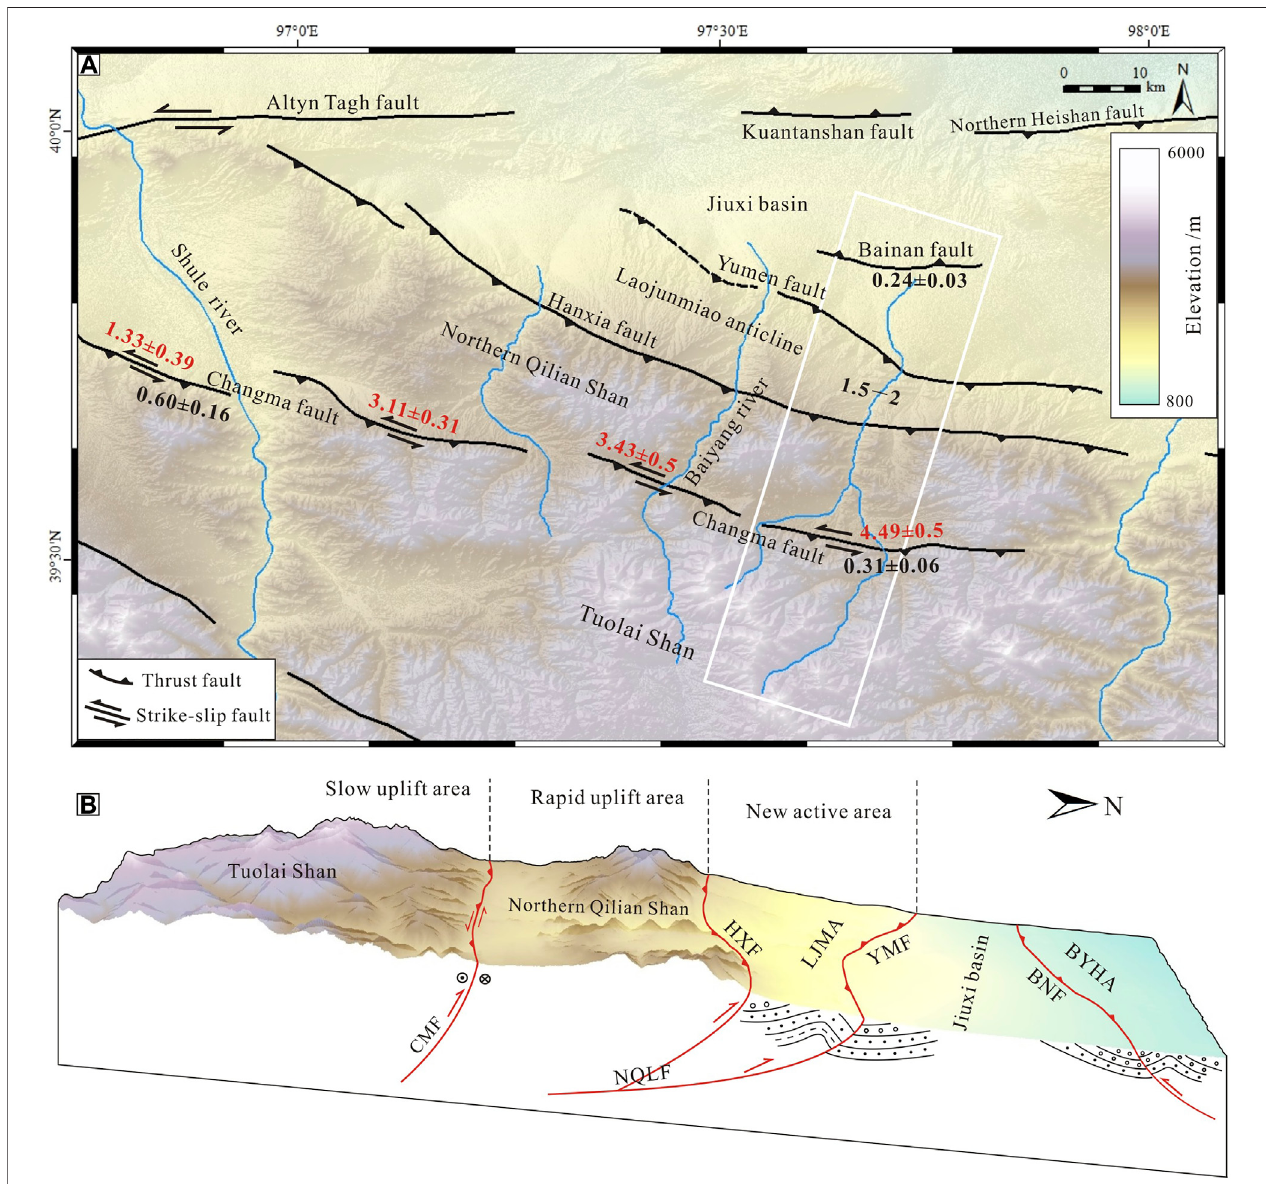
FIGURE 9 | (A) Slip rates of active faults in the northwestern Qilian Shan. The black numbers represent the uplift slip rates of the faults; the red numbers represent the sinistral slip rates of the faults. The slip unit is mm/a. The sinistral strike-slip rates of the Changma fault increase from west to east, but the vertical slip rates decrease fromwesttoeast. (B) Thethree-dimensionaltopographicmapoftheBaiyangrivercatchmentshowingthespatialvariationoftectonicactivityinthenorthernQilianShan. The range of the map is the white frame in panel (A) . Abbreviations of names: CMF, Changma fault; HXF, Hanxia fault; NQLF, Northern Qilian fault; LJMA, Laojunmiao anticline; YMF, Yumen fault; BNF, Bainan fault; BYHA, Baiyanghe anticline.